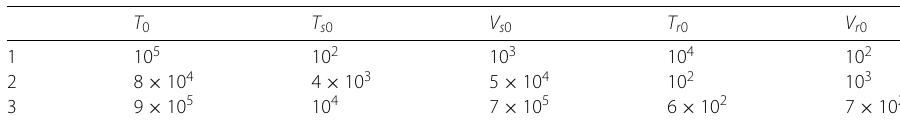
Table 2 Initial values of model (2)